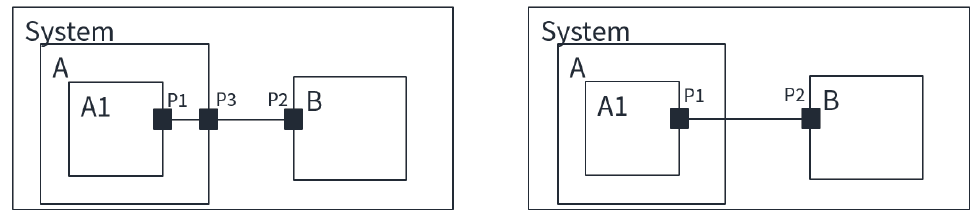
Figure 20. An example of block diagrams for a system with composed connections ( left ) that could be consistent with one connection ( right